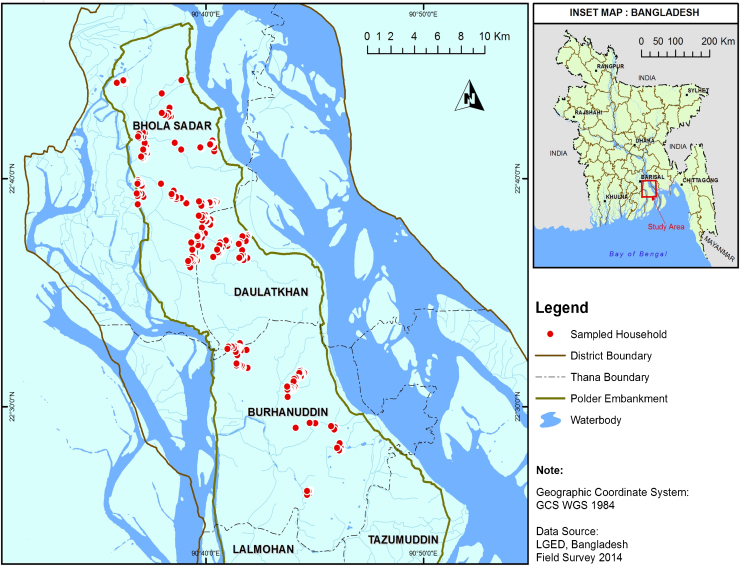
Sampled maize farming households on Bhola Island, Bangladesh.